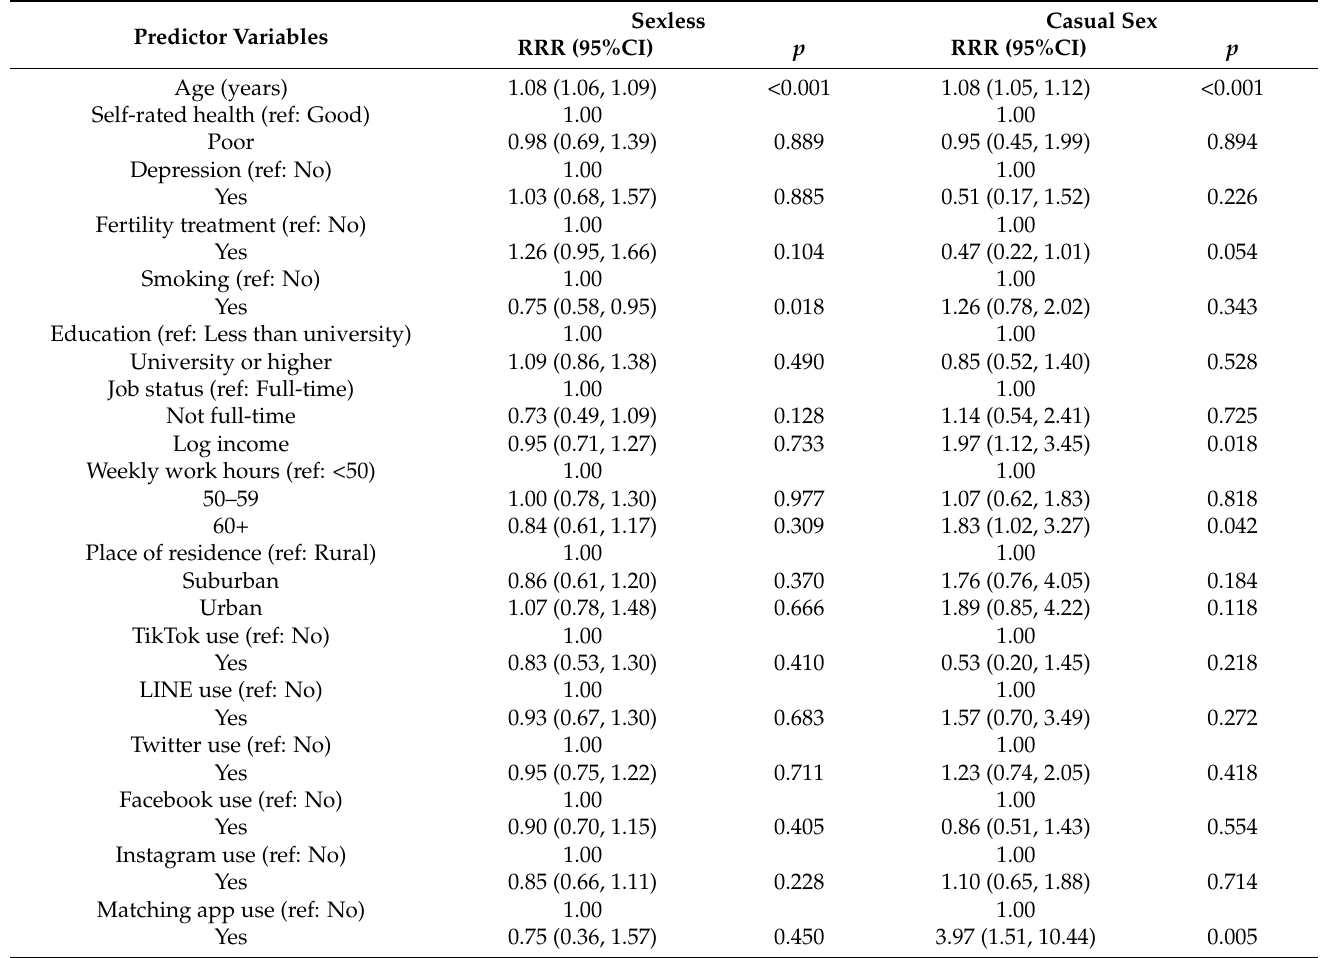
Table 4. Predictors of sexual behavior in the past month for married men in a multivariate multinomial logistic regression model ( n =